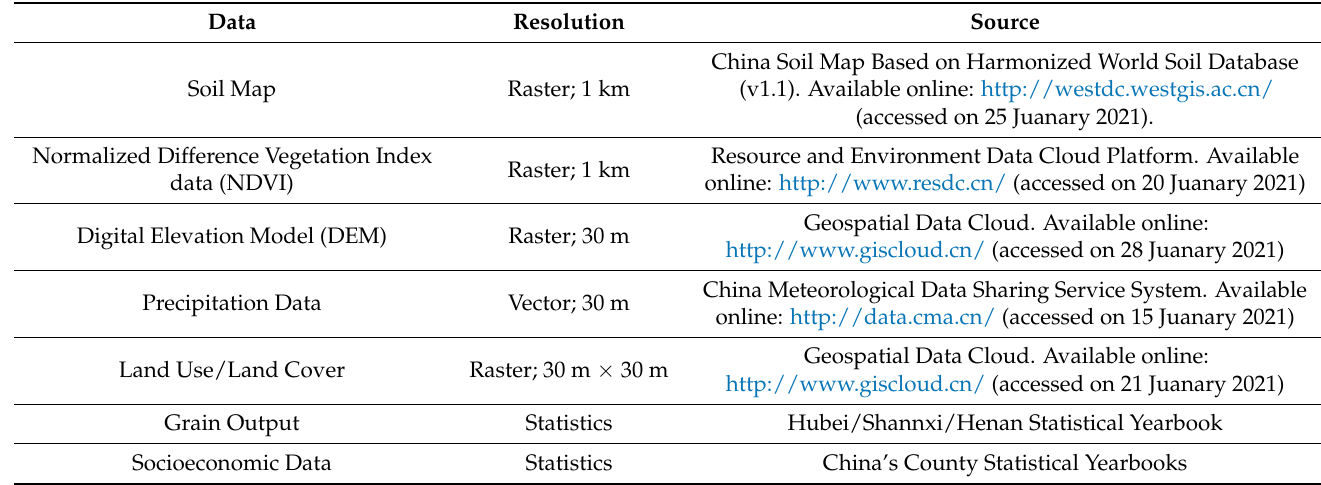
Table 1. Data description.